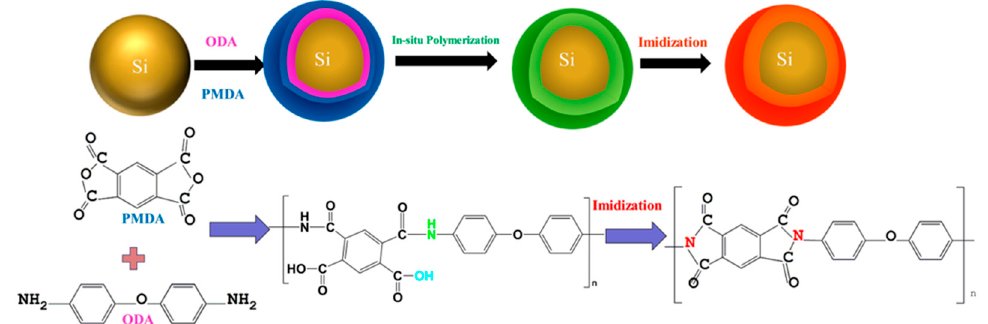
Figure 8. Schematic illustration of the synthesis procedure of Si@PI composites. Reprinted with per ‐ mission from Ref. [111]. 2022, Wiley.